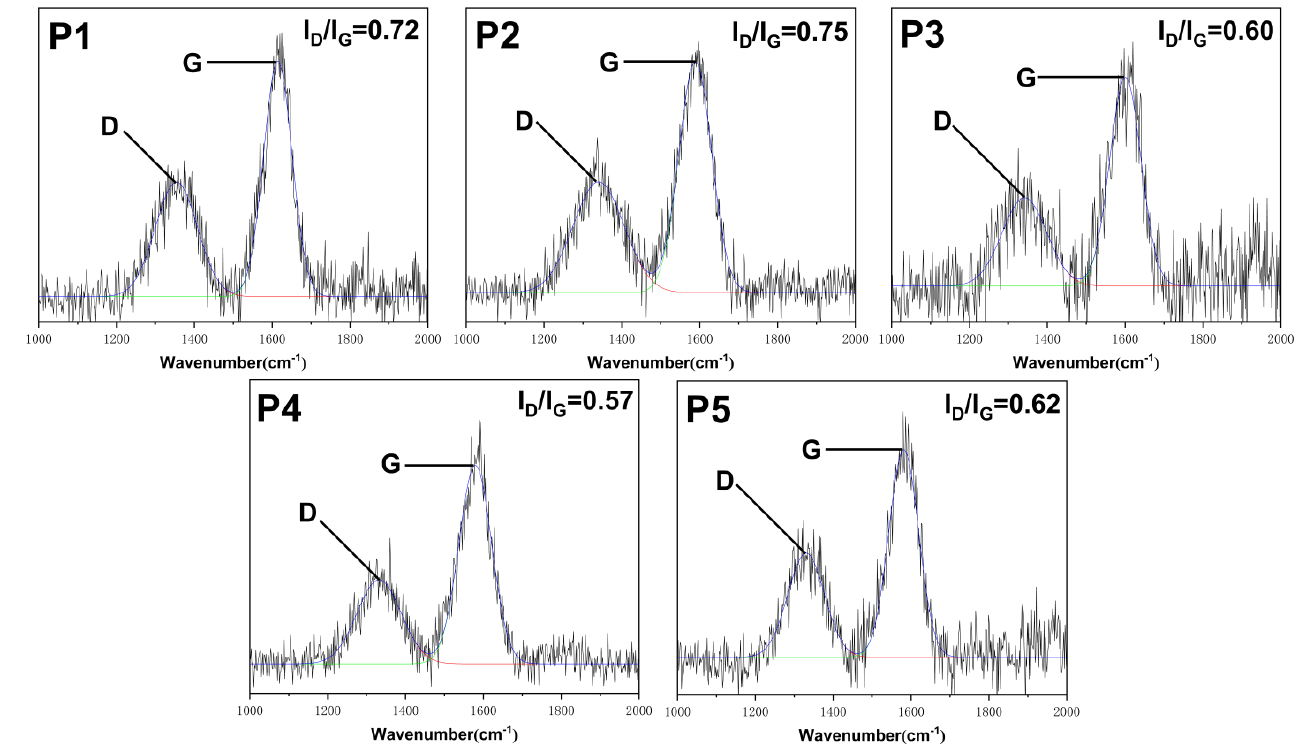
Figure 12. Raman analysis image of surface carbon layer.